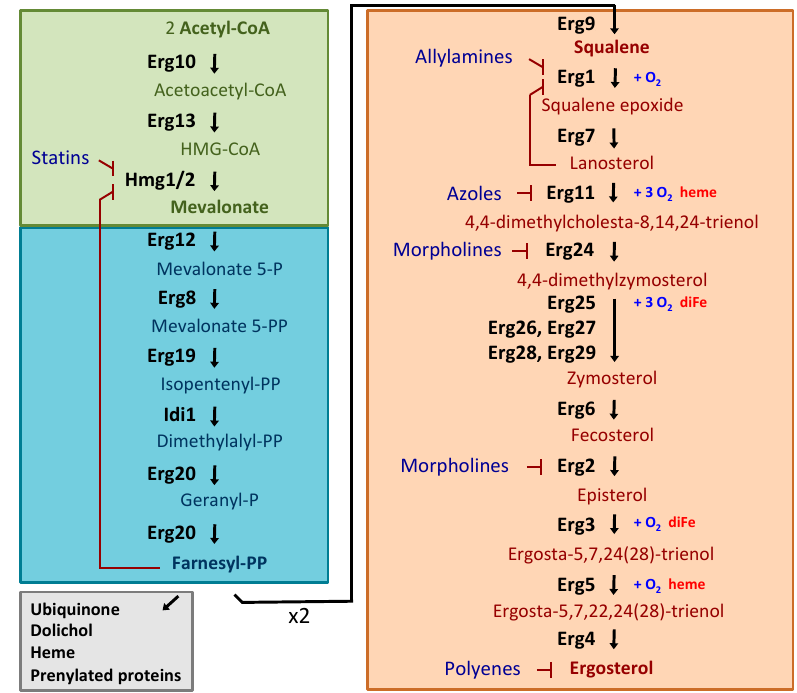
Figure 1. Ergosterol biosynthetic pathway in S. cerevisiae . The di ff erent color boxes represent the three modules into which the pathway can be divided: the green box is the mevalonate pathway, which occurs in the vacuole and mitochondria; the blue box consists of farnesyl pyrophosphate (farnesyl-PP) biosynthesis and is carried out in the vacuole; and the orange box contains the late pathway, which ends with ergosterol biosynthesis, and mainly takes place in the ER. In addition, farnesyl-PP is used in the synthesis of ubiquinone, dolichol, heme and prenylated proteins (gray box). Enzymes, intermediates, inhibitors and requirements of oxygen, heme and iron are indicated. Enzymes: Erg10, acetyl-CoA C-acetyltransferase; Erg13, HMG-CoA synthase; Hmg1 / 2, HMG-CoA reductase; Erg12, mevalonate kinase; Erg8, phosphomevalonate kinase; Mvd1 / Erg19, mevalonate pyrophosphate decarboxylase; Idi1, Isopentenyl diphosphate Isomerase; Erg20, farnesyl pyrophosphate synthetase; Erg9, squalene synthase; Erg1, squalene epoxidase; Erg7, lanosterol synthase; Erg11 (Cyp51), lanosterol C-14 demethylase; Erg24, sterol C-14 reductase; Erg25, sterol C-4 methyloxydase; Erg26, sterol C-3 dehydrogenase (C4-decarboxylase); Erg27, sterol C-3 ketoreductase; Erg6, sterol C-24 methyltransferase; Erg2, sterol C-8 isomerase; Erg3, sterol C-5 desaturase; Erg5, sterol C-22 desaturase; Erg4, sterol C-24 reductase. Inhibitors: statins target Hmg1 / 2; allylamines inhibit Erg1; azoles inhibit Erg11; morpholines target Erg2 and, mainly, Erg24; polyenes bind